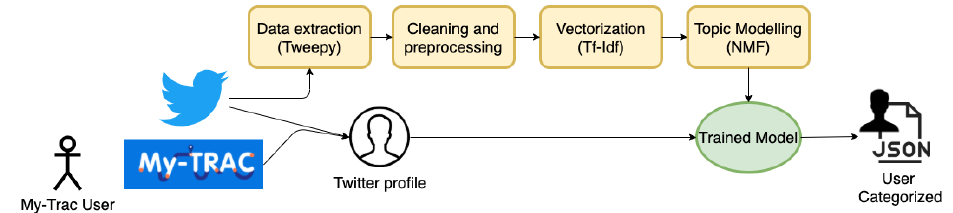
Figure 1. Pipeline representing the system processing